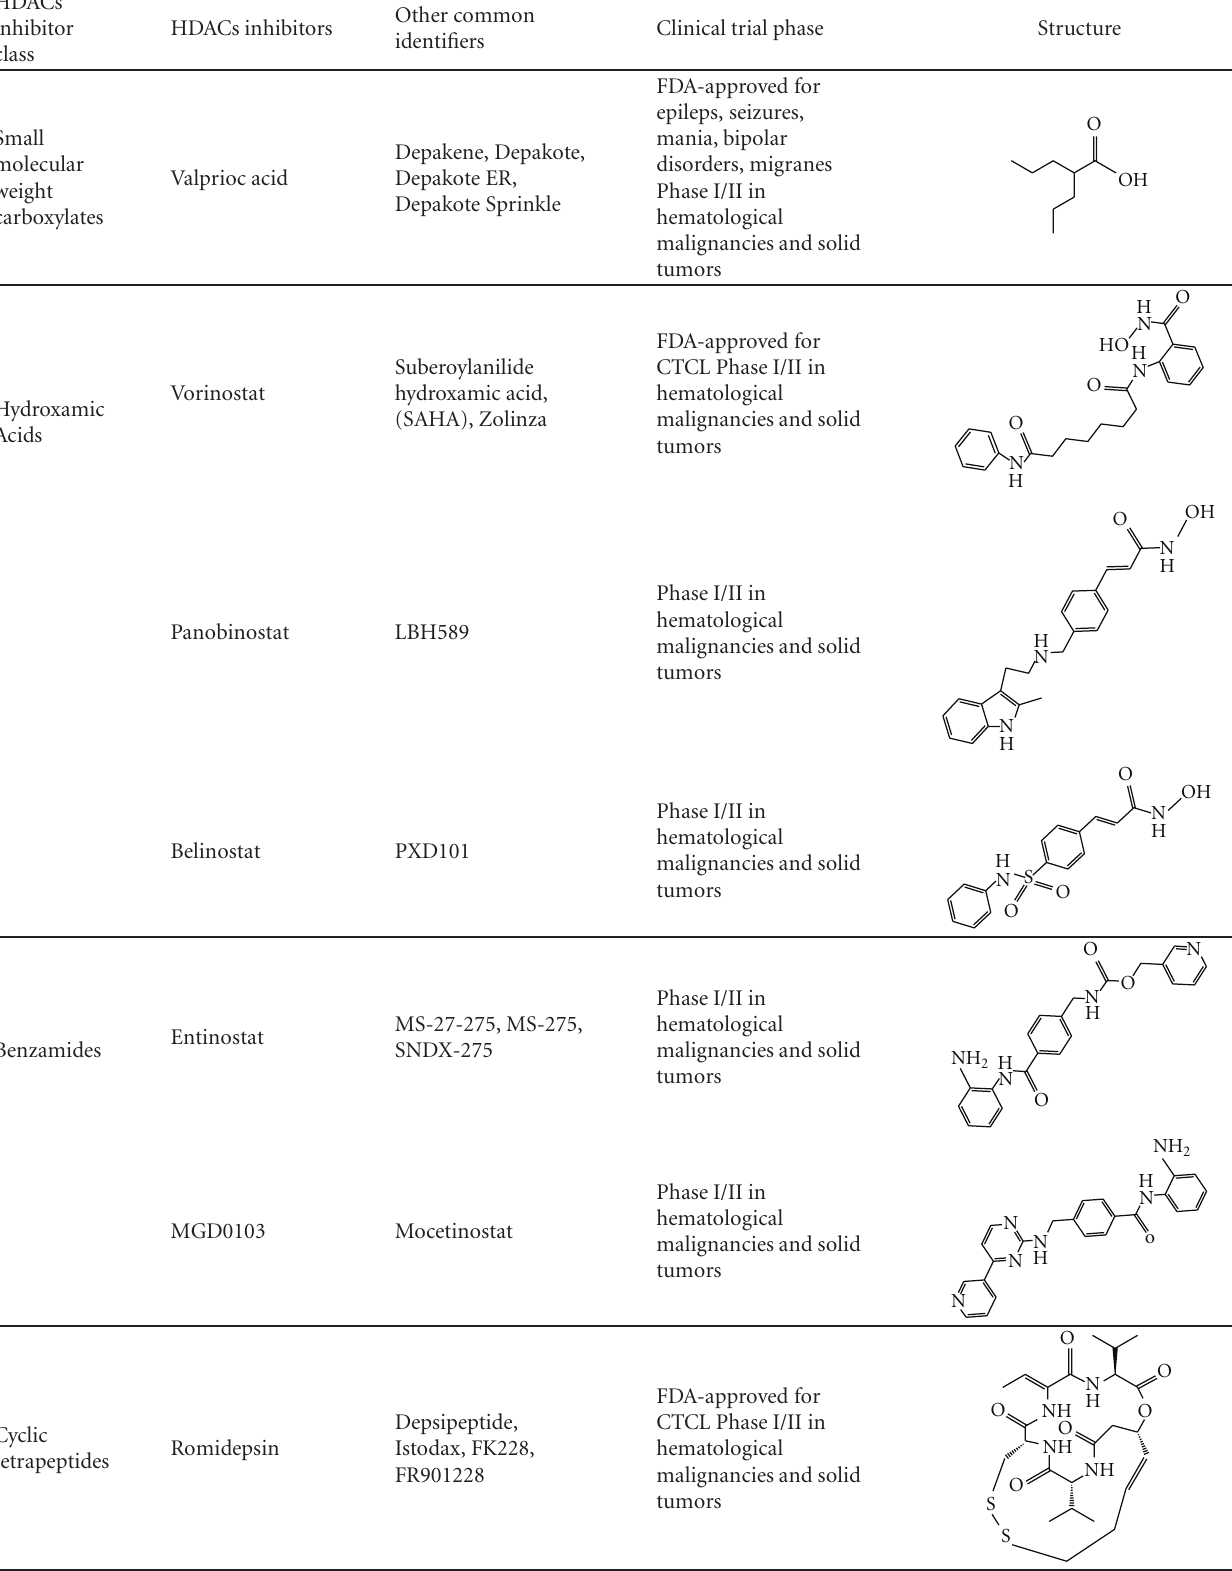
Table 1: Table of HDACs inhibitors discussed in this paper, organized by class (refer to text for references).